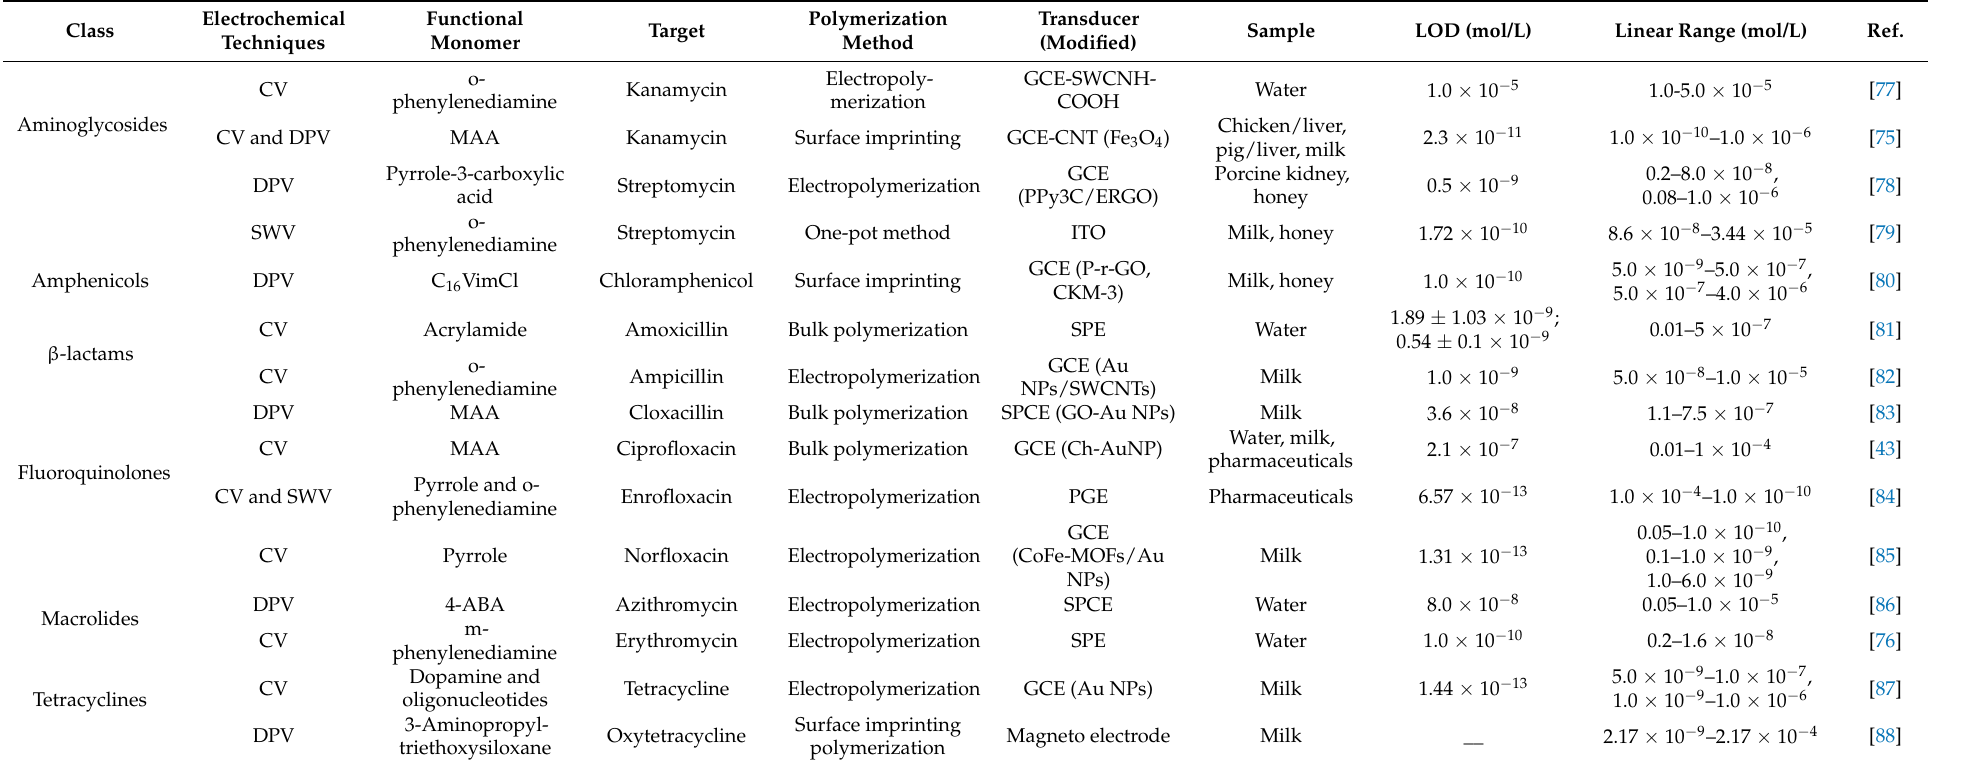
Table 2. Detection of food antibiotic residues using different MIP electrochemical biomimetic